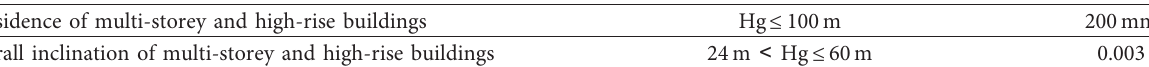
Figure 16: Building subsidence distribution. Table 4: Allowable values of buildings foundation deformation.